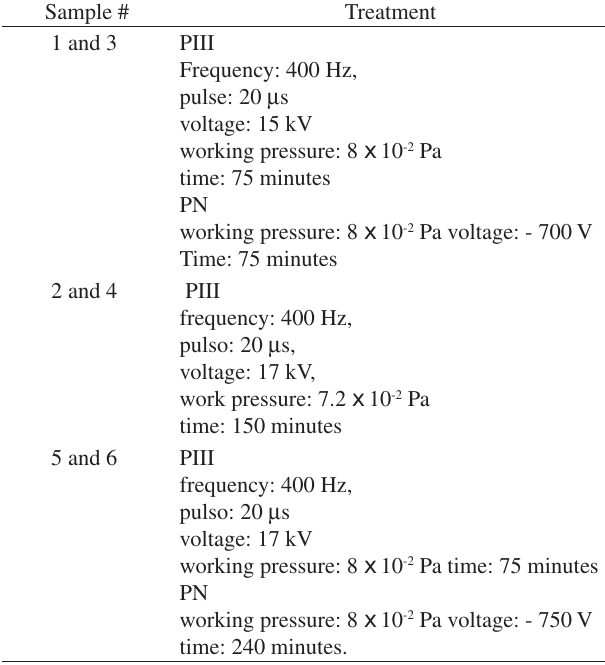
Table 1. Experimental parameters adopted in the tests. Sample #